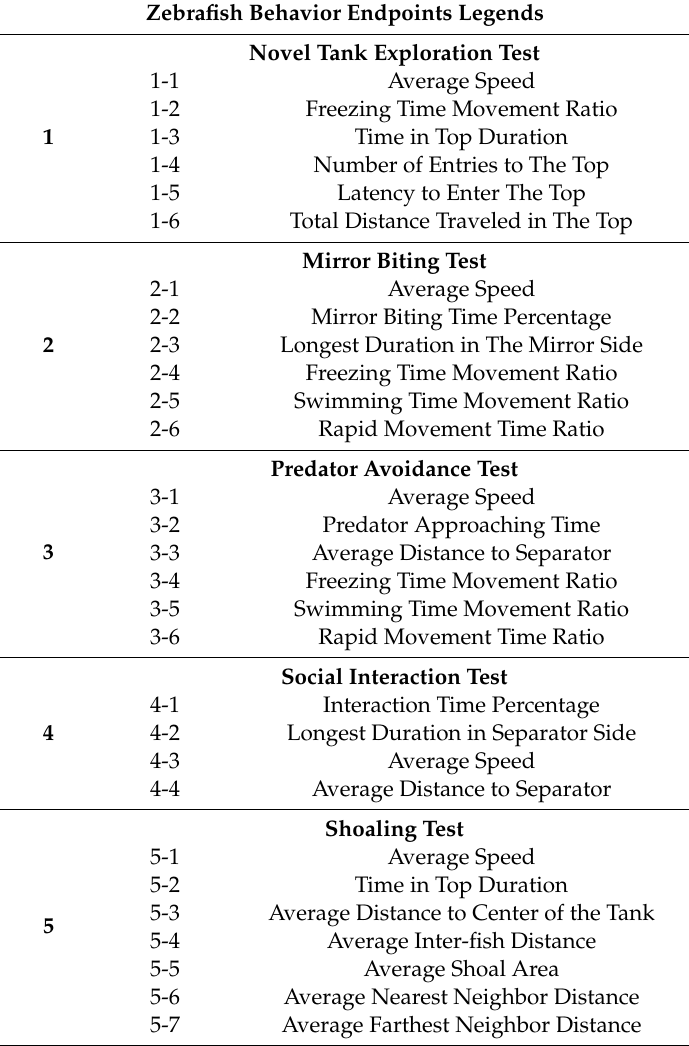
Table A1. Summary of behavior endpoints measured in this